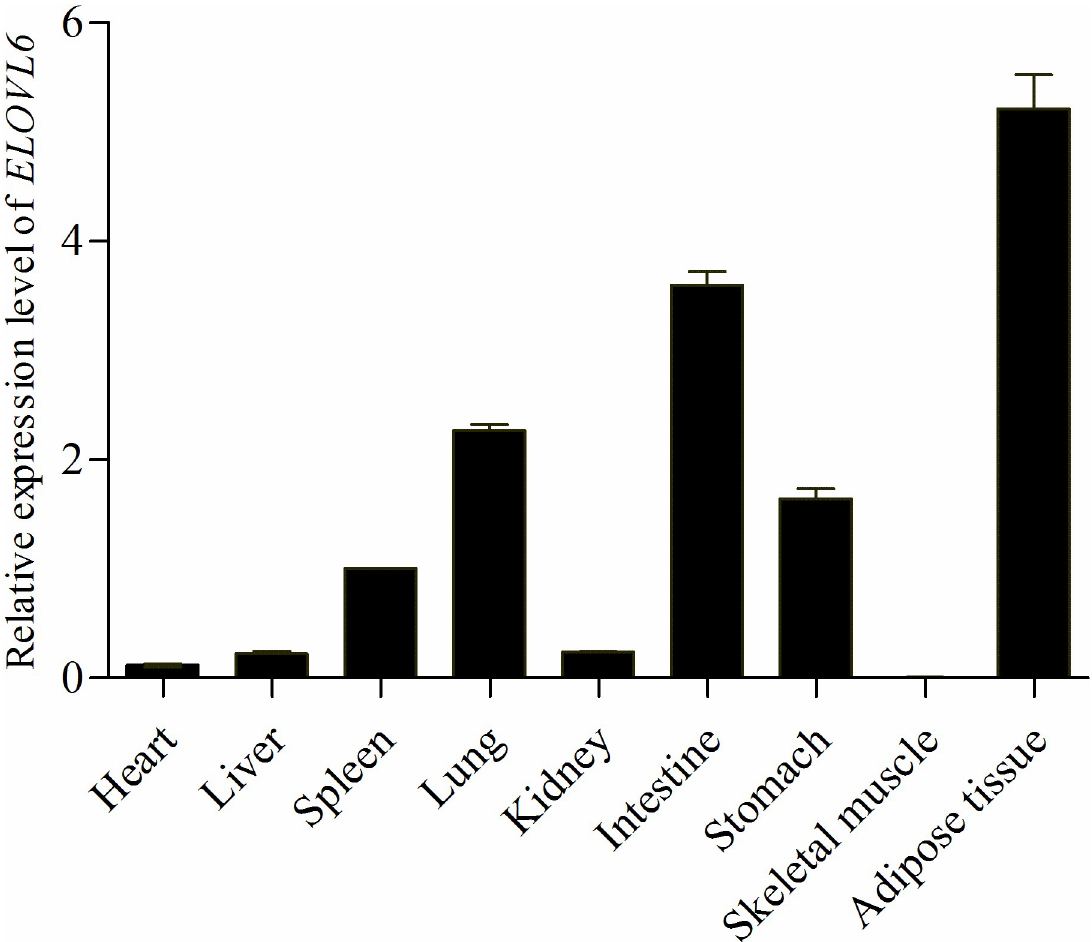
Fig 1. Tissue-specific expressionpatterns of bovine ELOVL6 mRNAs. Each column representedthe mean ± SD of three independentexperiments which were performed in